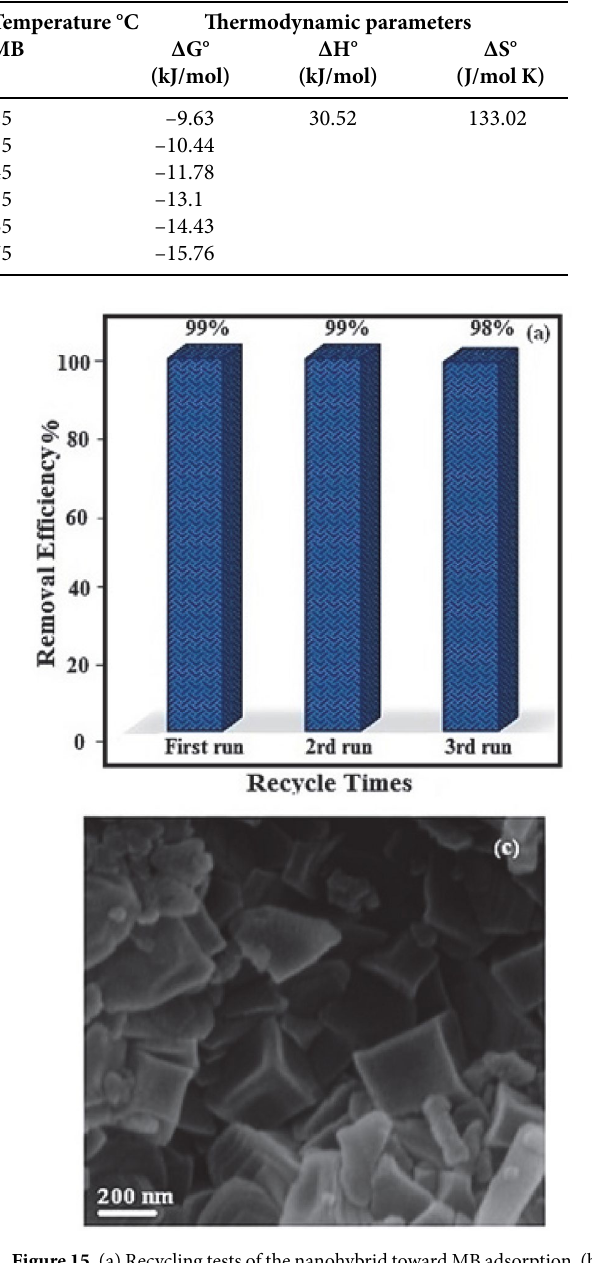
Figure 15. (a) Recycling tests of the nanohybrid toward MB adsorption. (b) FT-IR spectrum before and after adsorption (c) SEM image and (d) XRD pattern of the recovered nanohybrid after 3rd